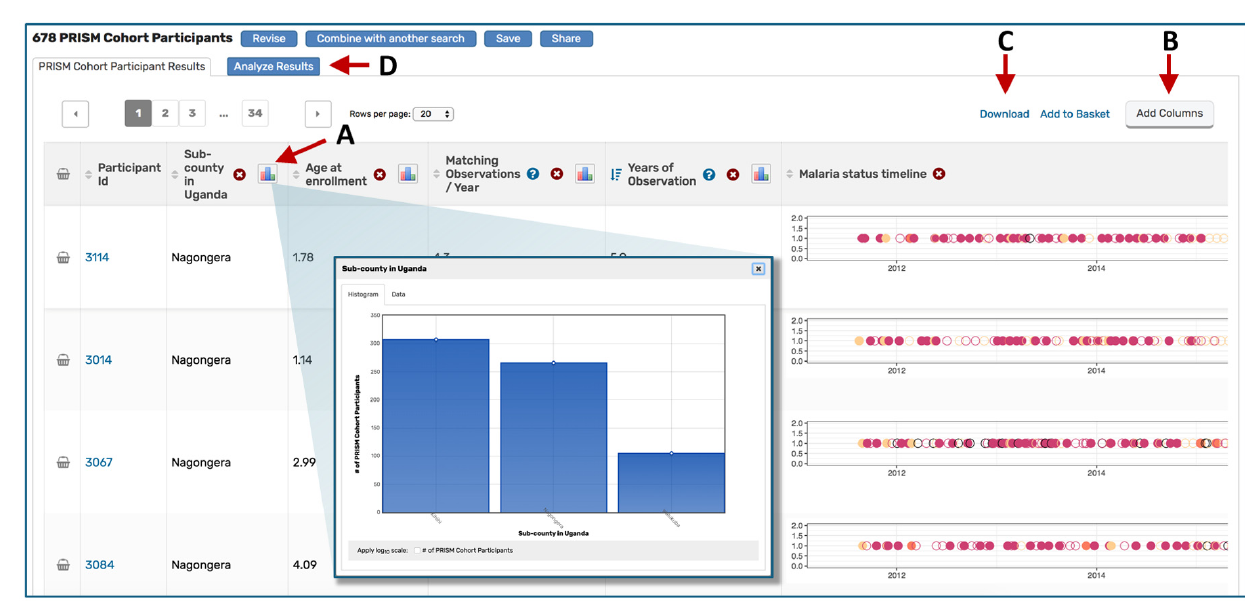
Figure 4. Using the Results Page. (A) Clicking a histogram icon opens a pop up showing the distribution of data for that variable. (B) The “Add columns” button allows users to change which variables are shown in the table. (C) The “Download” link directs users to a page where they can choose which variables to download. The data subset is based on the selections applied in the Search Wizard. (D) The “Analyze Results” tab leads to a suite of applications for further data visualization.